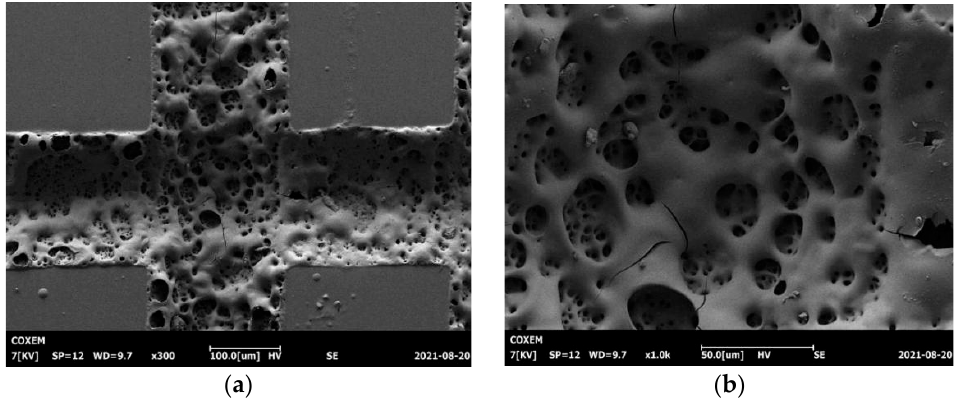
Figure 15. Morphology of processing groove (scanning electron microscope): ( a ) Morphology map under 300× magnification; ( b ) Morphology map under 1000× magnification.